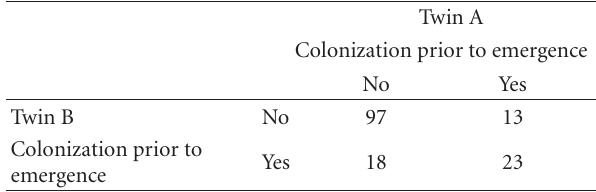
Table 3: Associations between MZ co-twins (Twin A and B) for colonization prior to emergence of the first